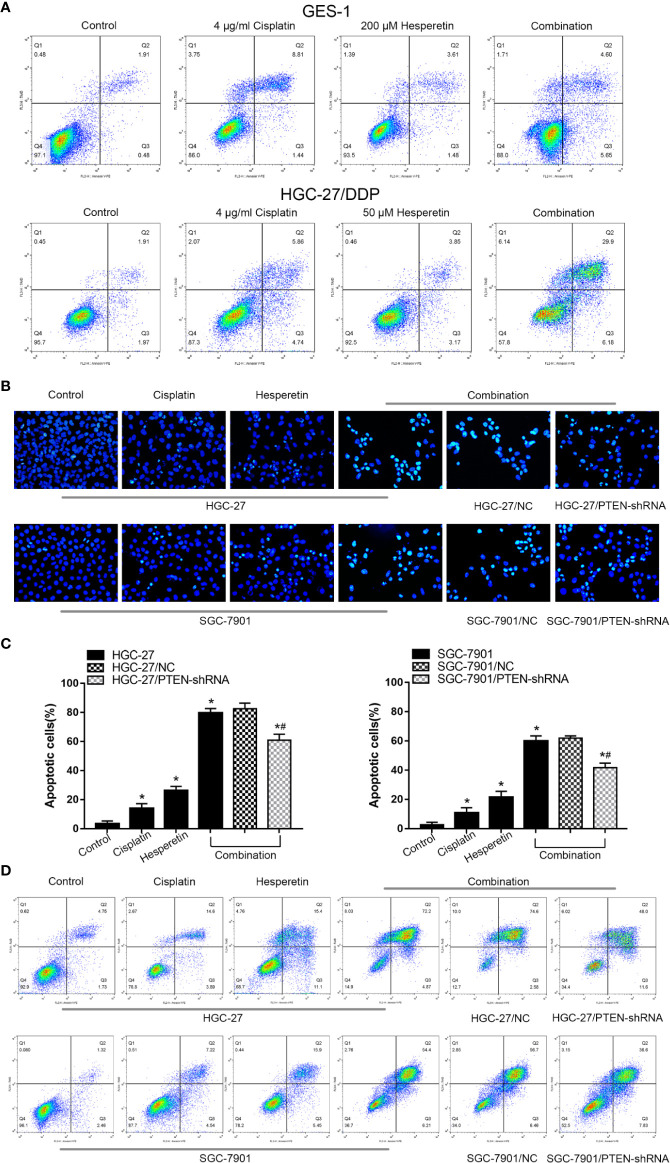
Hesperetin promotes the cisplatin-induced apoptosis of GC cells. (A) Quantitative flow cytometry measurements of apoptosis in GES-1 (control, 4 μg/ml cisplatin, 200 µM hesperetin, or 4 μg/ml cisplatin + 200 µM hesperetin) and HGC-27/DDP (control, 4 μg/ml cisplatin, 50 µM hesperetin, or 4 μg/ml cisplatin + 50 µM hesperetin) (B) Original magnification: 200×. HGC-27 (SGC-7901) cells were treated with control, 4 μg/ml cisplatin, 200 µM hesperetin, or 4 μg/ml cisplatin + 200 µM hesperetin; HGC-27(SGC-7901)/NC and HGC-27(SGC-7901)/PTEN-shRNA were treated with 4 μg/ml cisplatin + 200 µM hesperetin. (C) Quantitative analysis of the apoptosis rate in each group. *P < 0.05 vs. the control; *#P < 0.05 vs. NC cells. (D) Quantitative flow cytometry measurements of apoptosis in GC cells. All the above data are the mean ± SD from an average of three experiments.